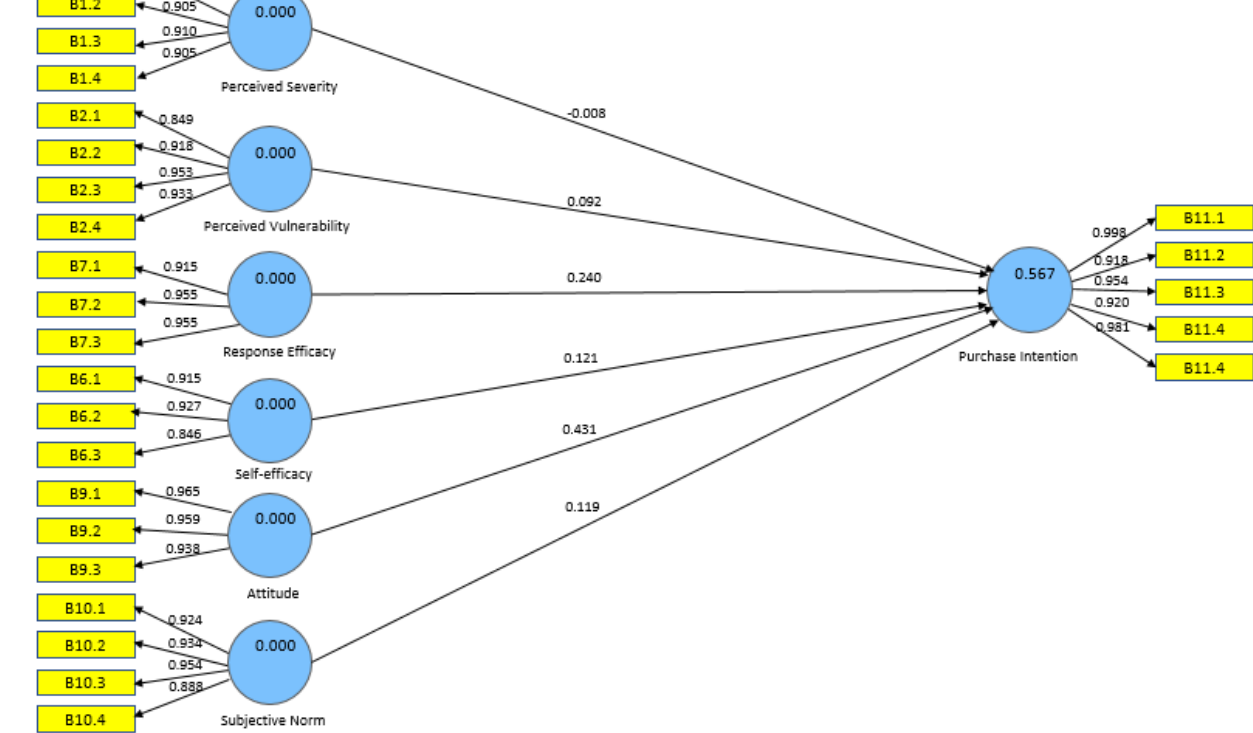
Figure 3. A multi-theoretical approach model.